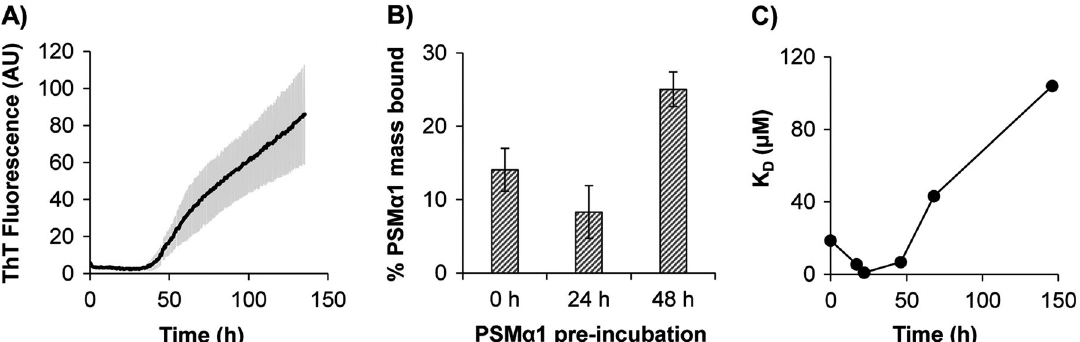
Fig. 6 Designed α -sheet peptides preferentially bind α -sheet-rich PSM α 1 over fresh or fi brillar PSM α 1. a Synthetic PSM α 1 peptides (30 μ M, 0.34% DMSO, pH 5) were allowed to aggregate as in Fig. 5, and matched samples were removed periodically from the plate for binding assessment using an agarose bead, resin-based assay and biolayer interferometry. Error bars represent the standard deviation of six samples. b In the resin-based assay, AP193-functionalized beads preferentially bound α -sheet rich PSM α 1 (48 h) over earlier time points (0 and 24 h). Error bars represent the standard error of the mean over six samples. c In biolayer interferometry experiments, the equilibrium dissociation constant, K D , indicates preferential binding between AP90 and α -sheet-rich PSM α 1 (~48 h) as opposed to α -helix-rich (~0 h) or β -sheet-rich states (~150 h). Note that 150 h is still in the sigmoidal region of the transition and some α -sheet is